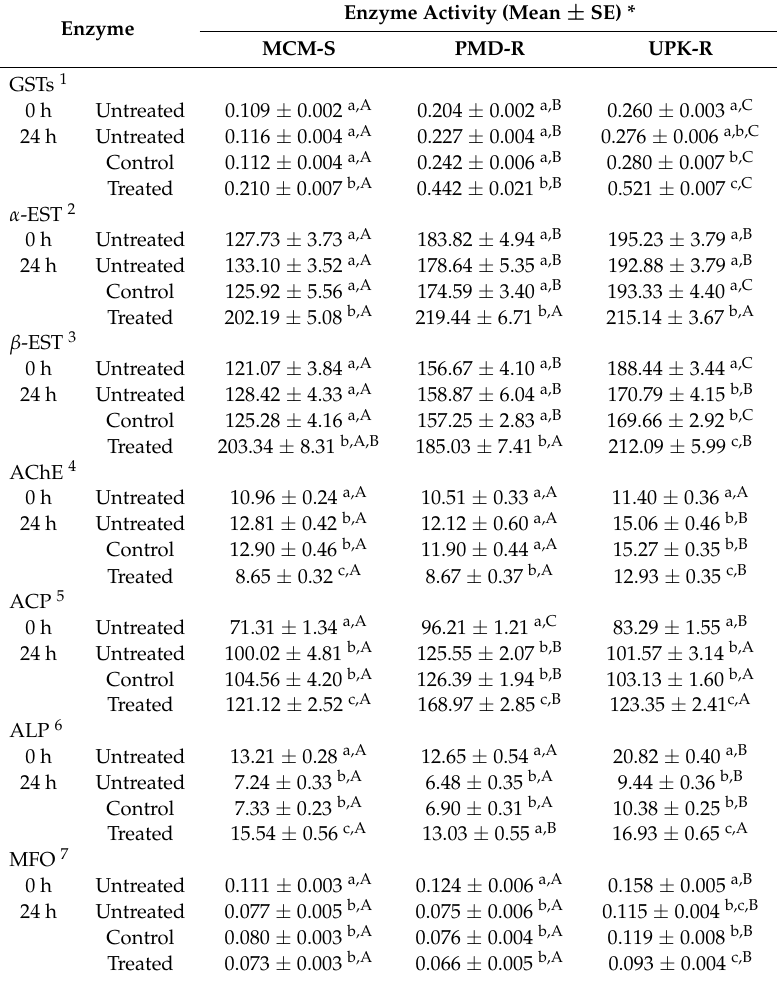
* Values followed by different lowercase letters in a column and uppercase letters in a row are significantly different (Tukey’s HSD test, p < 0.05); 1 GSTs activity was expressed as µ mol/min/mg protein; 2 α -EST activity was expressed as nmol/ α -naphthol released/min/mg protein; 3 β -EST activity was expressed as nmol/ β -naphthol released/min/mg protein; 4 AChE activity was expressed as nmol/min/mg protein; 5 ACP activity